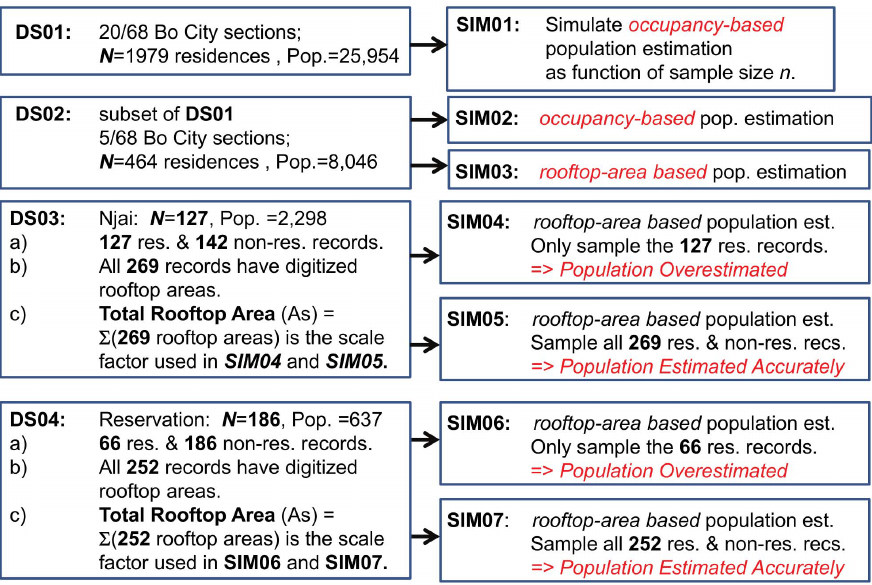
Figure 2. Flowchart illustrating datasets and simulations.